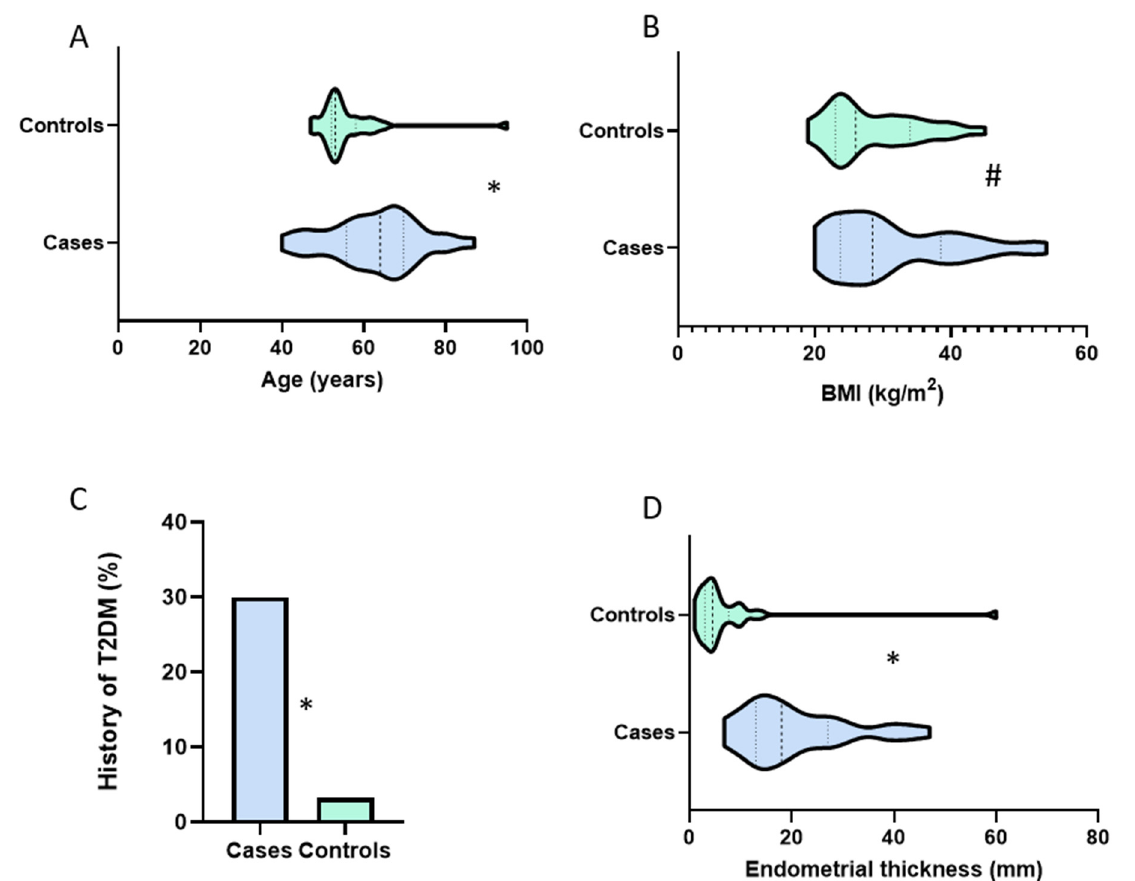
Figure 1. Demographic and clinical characteristics of the discovery cohort by disease status (cases: n = 31; controls: n = 30). ( A ) Age distribution; ( B ) BMI; ( C ) History of type 2 diabetes mellitus (T2DM); ( D ) Endometrial thickness. Statistical significance was determined by the nonparametric Mann–Whitney test for A, B, and D, and the chi-squared test for C. The p -values portrayed with * indicate p < 0.05 while # indicates p ≥ 0.05.